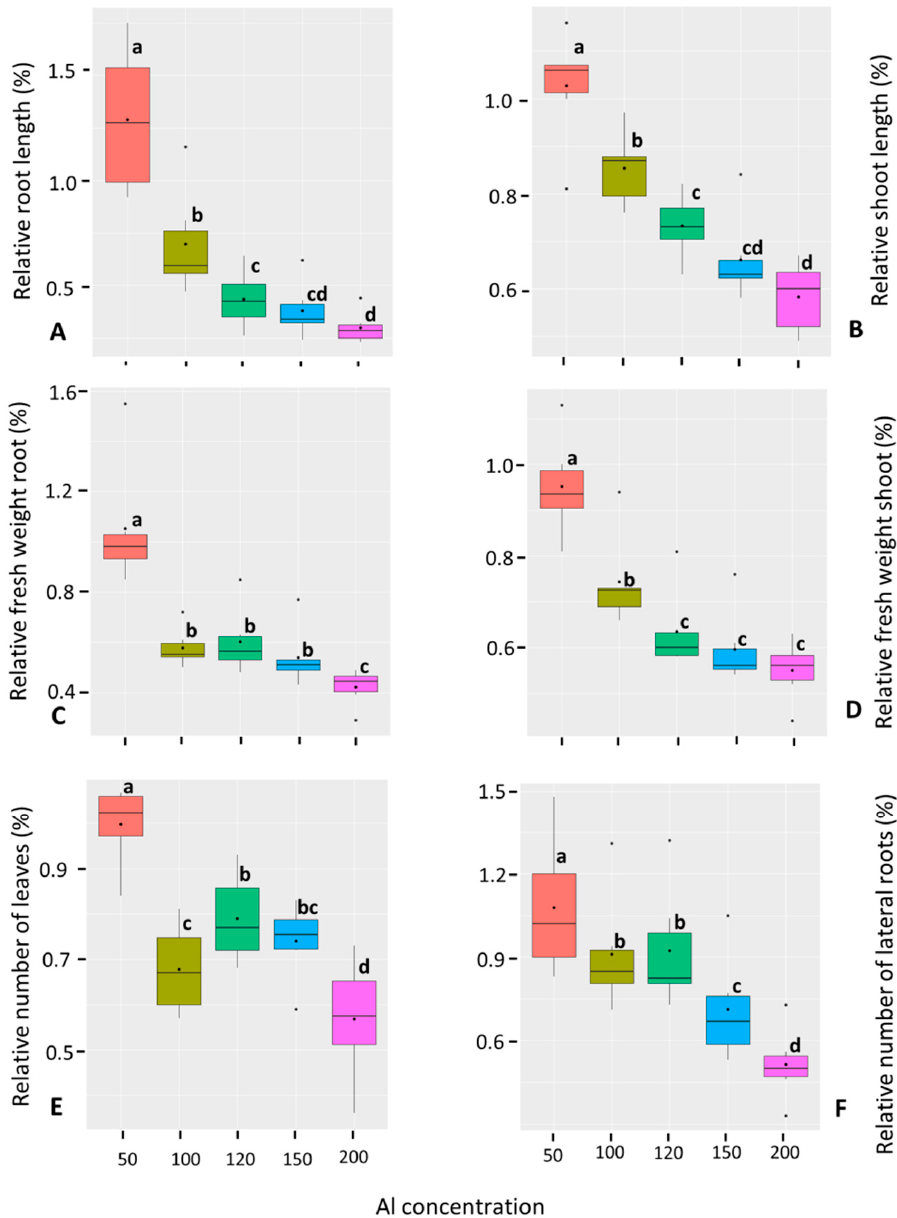
Figure 1. Main effect of increasing aluminum concentration on chickpea seedling traits. ( A ) Relative root length (% RL); ( B ) relative shoot length (% SL), ( C ) relative fresh weight root (% FWR); ( D ) relative fresh weight shoot (% FWS); ( E ) relative number of leaves (% NL); ( F ) relative number of lateral roots (% NLR). Data represent the normalized values for each trait expressed relative to 0 µ M Al for each genotype and aggregated among the six different cultivated accessions. All solutions were at pH 4.5. Box plots delimit the mid-50% range of trait values. Horizontal lines in the plot represent the median of each trait’s values. Vertical lines extending from each box represent ranges of values among all genotypes. Box plots with the same letter are not significantly different from each other.